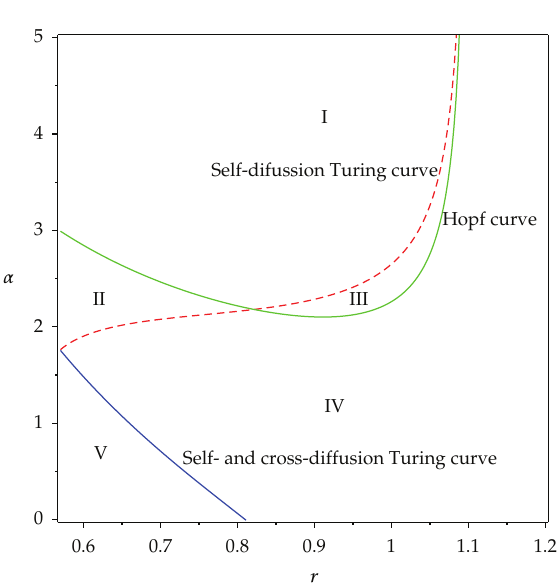
Figure 1: The dispersal relation of r with α . Parameters: β (cid:5) 1 . 3, d 11 (cid:5) 0 . 2, d 12 (cid:5) 0 . 05, d 21 (cid:5) 0 . 35, d 22 (cid:5) 0 . 2. The green, red, and blue curves represent Hopf, self-di ff usion Turing, and self-cross-di ff usion Turing bifur- cation curve, respectively. They separate the parametric space into five domains, and domain (cid:7) IV (cid:8) is called Turing